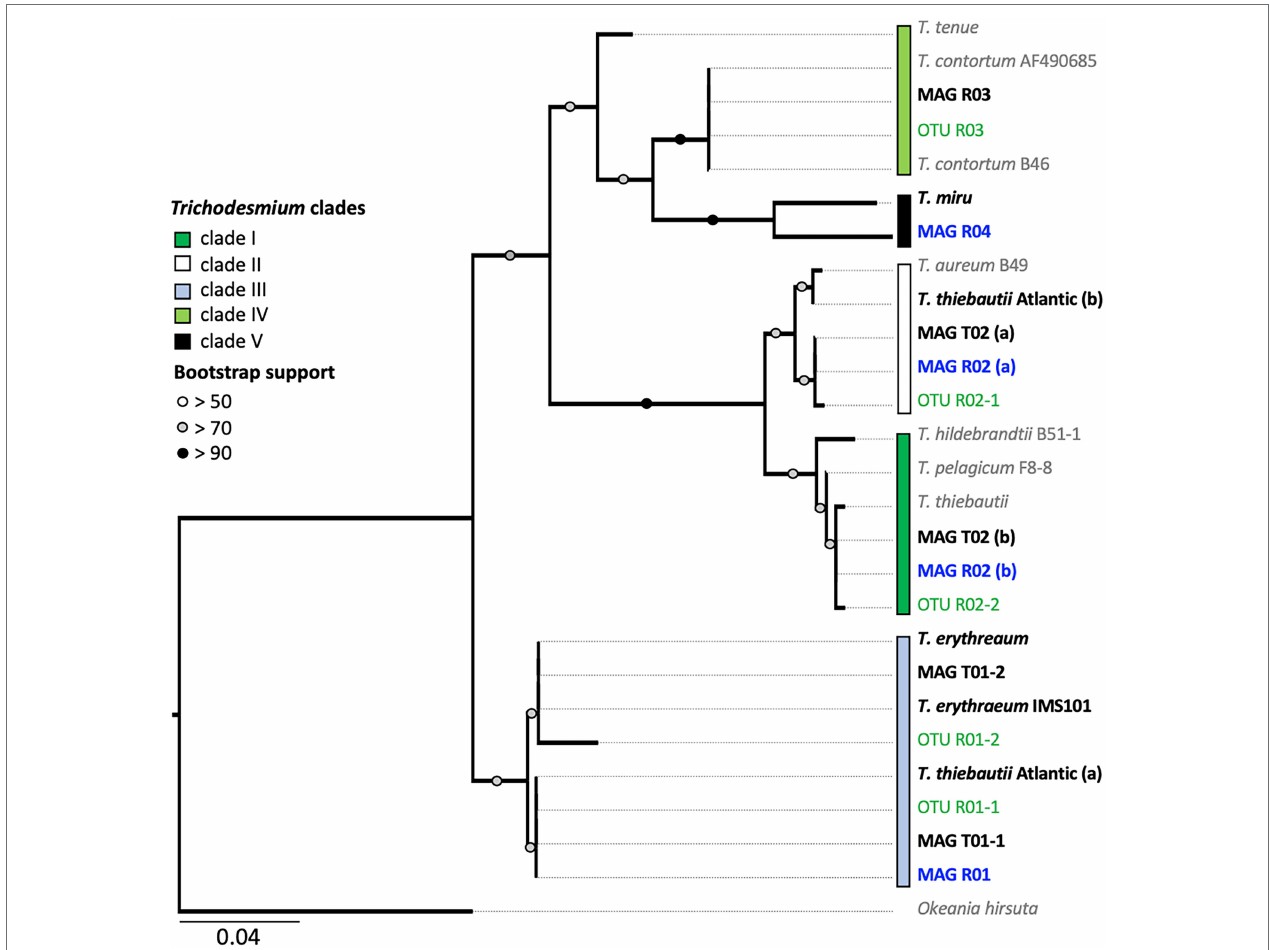
FIGURE 3 | Trichodesmium hetR phylogeny. The tree is based on the alignment of 312 nucleotide sequences. Bold text indicates the hetR sequences from metagenome-assembled genomes (MAGs; Red Sea sequences are marked in blue). Amplicon hetR sequences are shown in green. The five proposed Trichodemium clades are shown with colored boxes. Note that clades IV and V are polyphyletic and are therefore not completely resolved. MAGs R02 and T03 contain two hetR sequences, clustering within clades I and II, respectively. The average percentage identity (ANI) matrix between the hetR gene sequences can be found in Supplementary Table 4